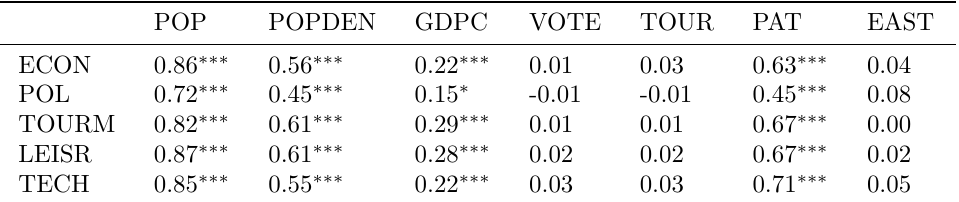
Table C.1: Correlation between frequency of press releases in economy, politics, tourism, leisure, and technology topics, and regional socio-economic variables POP POPDEN